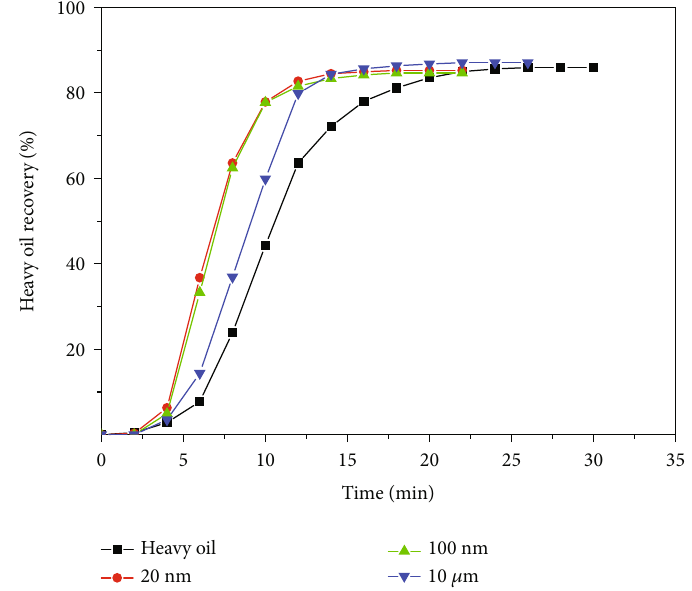
Figure 12: The experimental heavy oil recovery curves of each group under di ff erent water content.